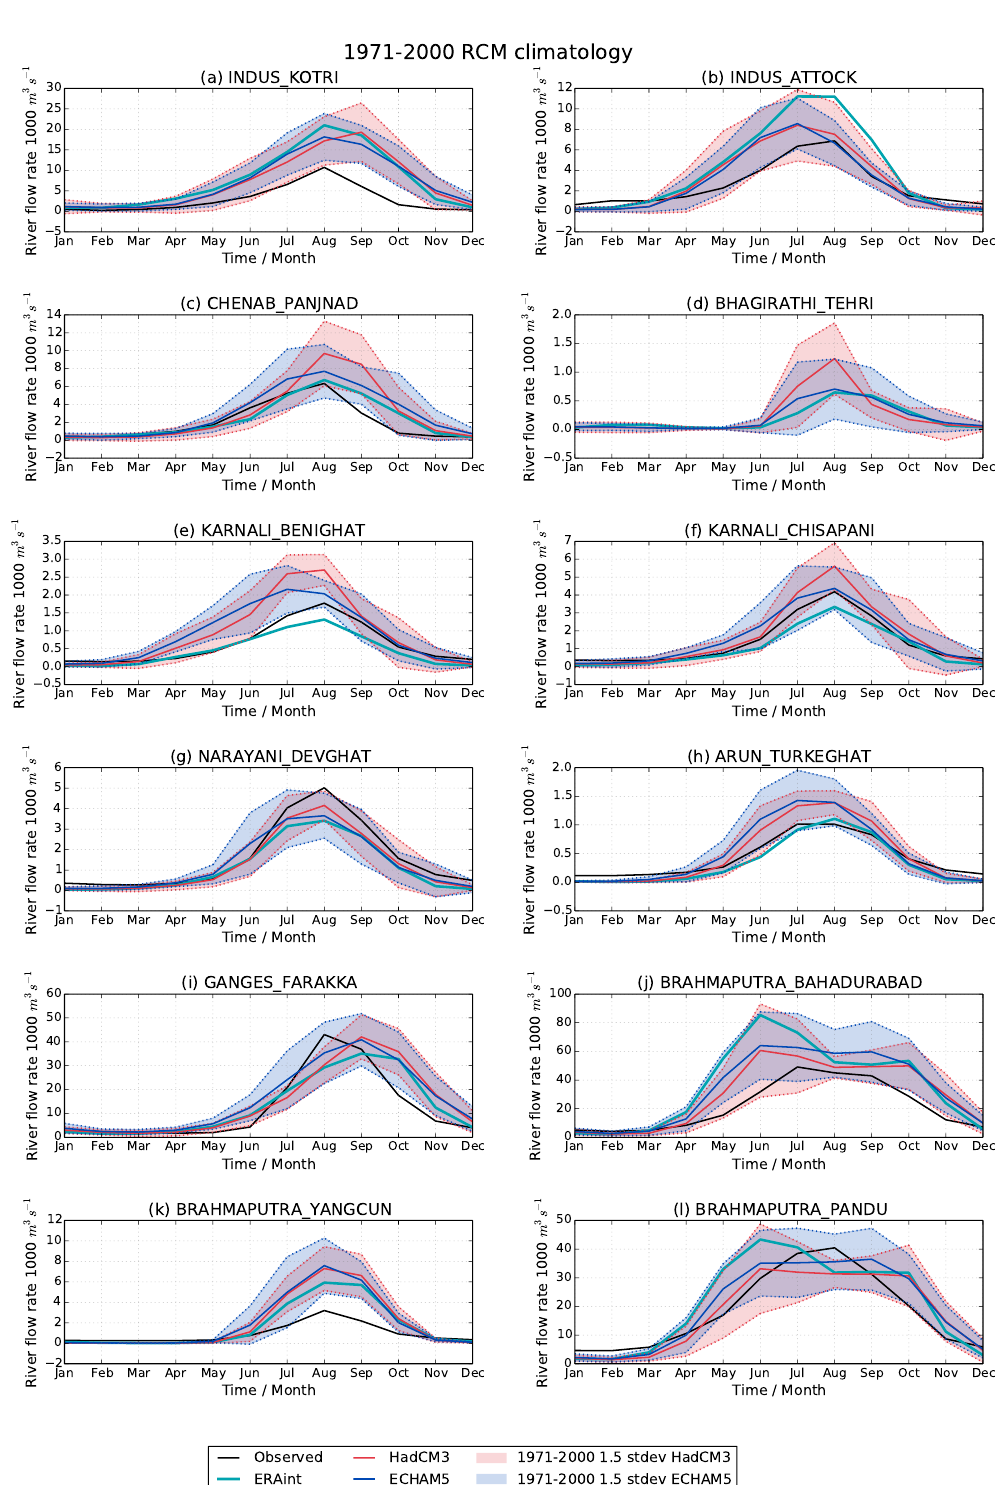
Figure 9. Seasonal cycle of river flow at individual river gauges; observed (black solid line) and for each of the RCMs (HadCM3 – red, ECHAM5 – blue, ERAint – cyan lines) from 1971 to 2000; with shaded regions showing 1.5SD from the mean for the two simulations for the same